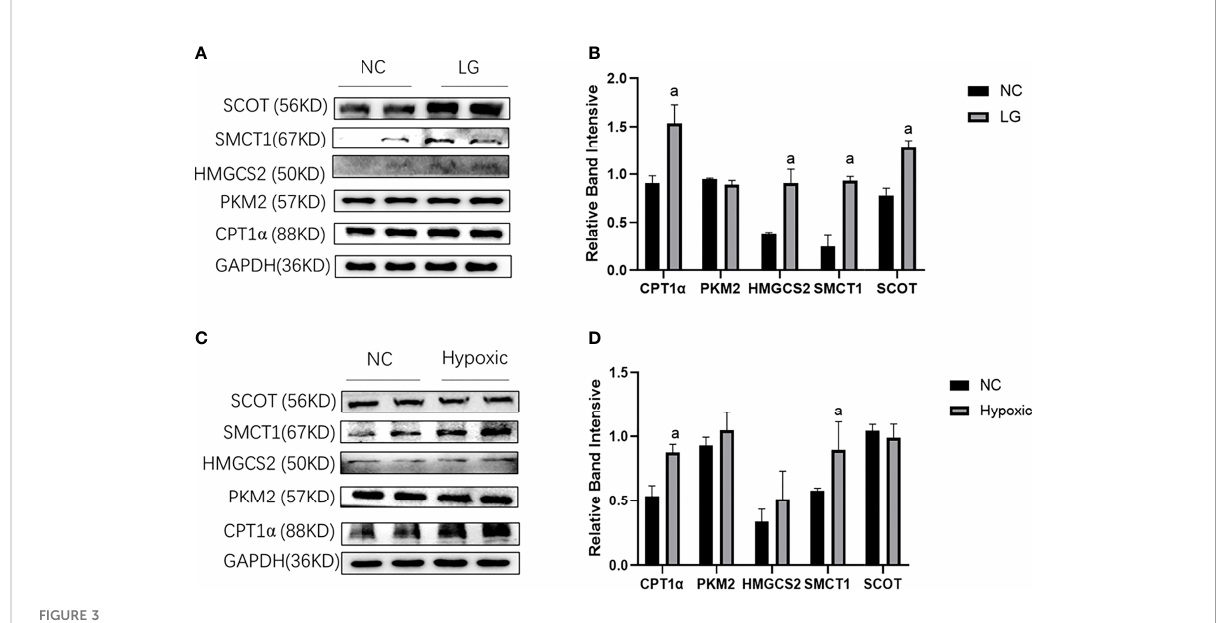
FIGURE 3 Metabolic fl exibility of HK2 cells under low glucose and oxygen conditions. (A, B) Expression of CPT1 a , PKM2, HMGCS2, SMCT1, and SCOT in HK2 cells under hypoglycemic environment; (C, D) Expression of CPT1 a , PKM2, HMGCS2, SMCT1, and SCOT in HK2 cells under hypoxic condition; a p < 0.05, compared with the NC